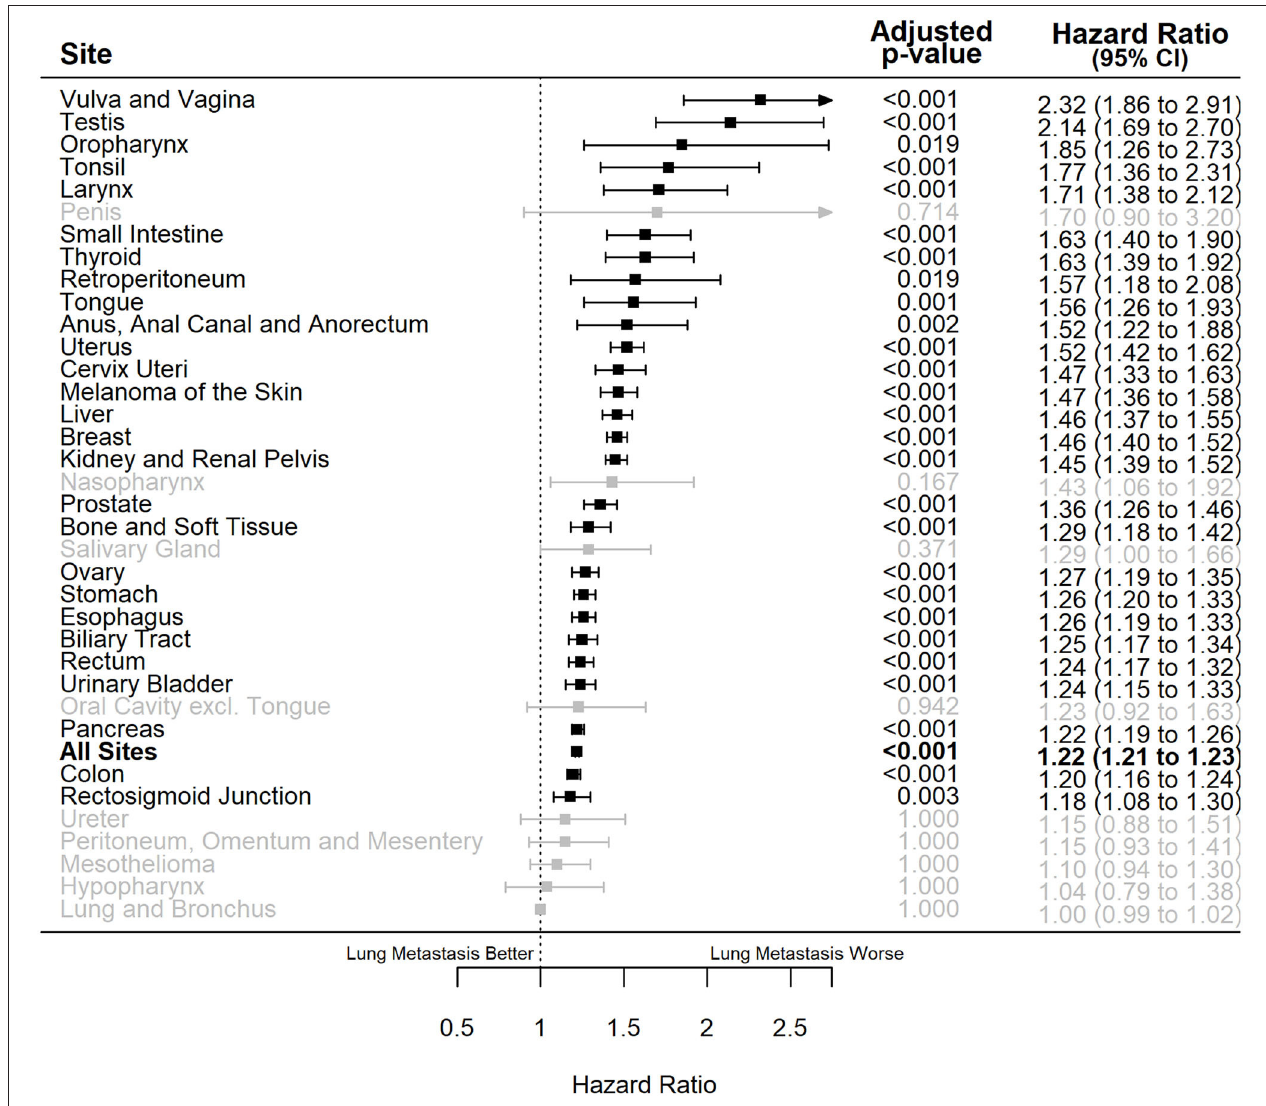
FIGURE 4 | Forest plot of adjusted hazard ratios of death (x-axis) for de novo metastatic cases with lung metastasis vs. those with only extrapulmonary metastases for different primary sites of origin (y-axis). Bold: the overall effect estimate for all sites, black: statistically significant individual primary sites, gray: non-statistically significant individual primary sites. Adjusted P -values represent those corrected for multiple testing. CI, confidence interval.